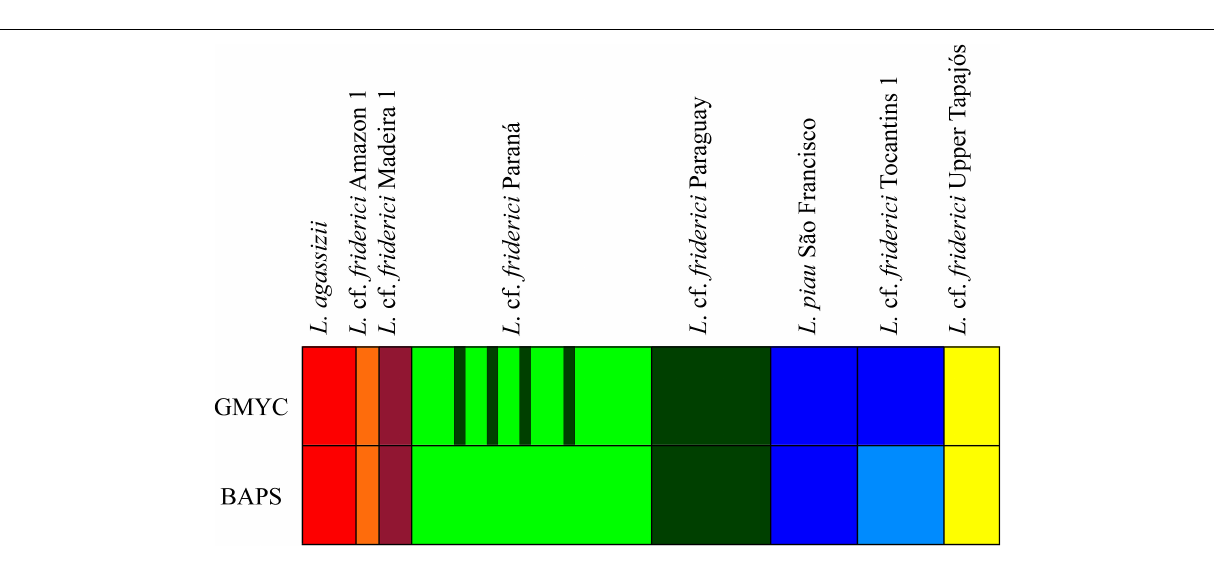
FIGURE 3 | MOTUs identified based on the GMYC and BAPS analyses for Leporinus cf. friderici sensu stricto